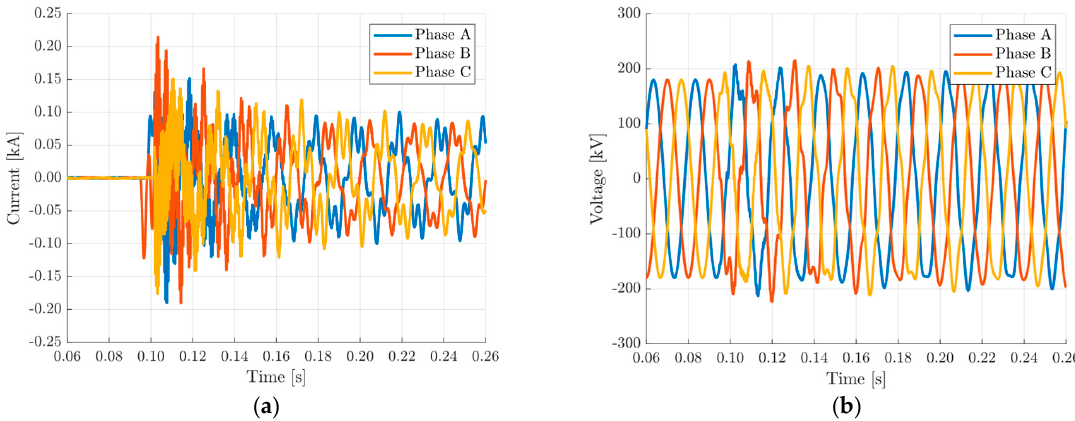
Figure 5. Simulation results with a synchronous generator as the self-start unit in the simplified benchmark system after closing breaker BRK2, thus energising the submarine cable: current ( a ) and voltage ( b ) waveforms.